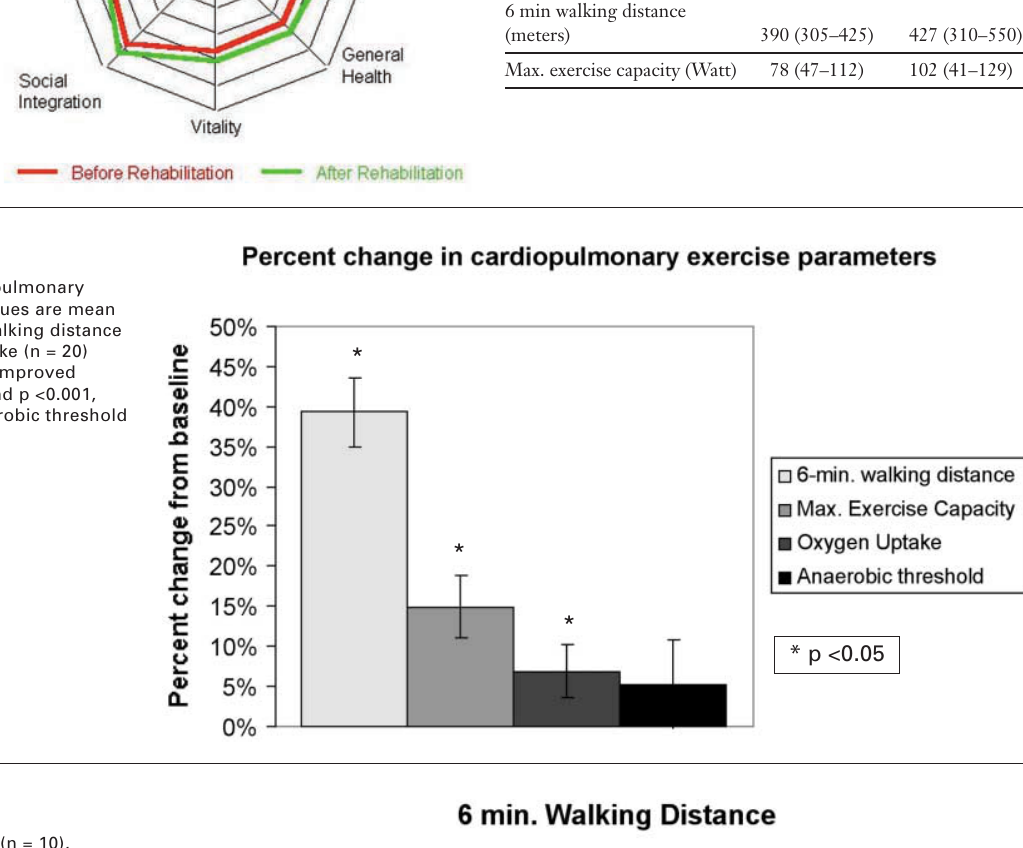
Scores of the 8 SF-36 categories. Seven of 8 items improved after the rehabilita- tion programme (p <0.05). Represen- tation of the diagram according to Steiner et al. [15].